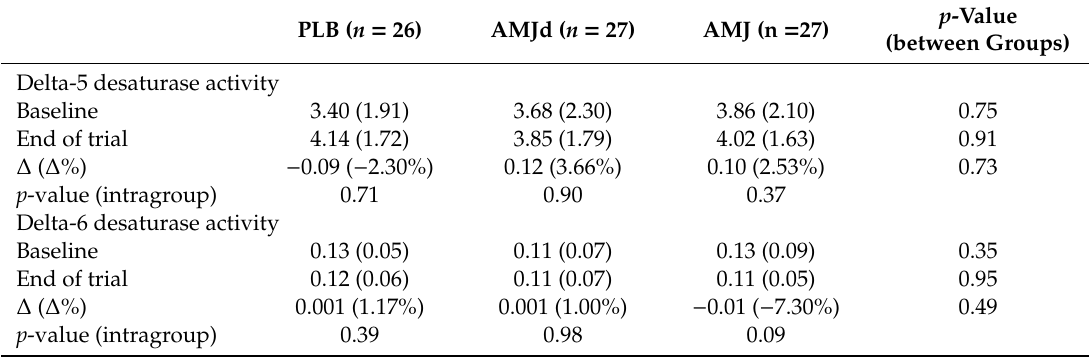
high-dose chokeberry juice